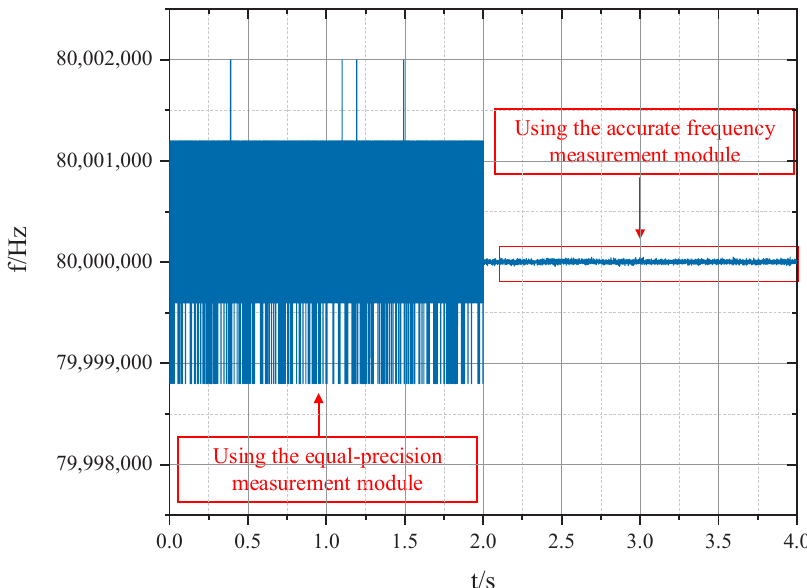
Figure 14. Comparison of frequency measurement results between the proposed method and the equal-precision method.